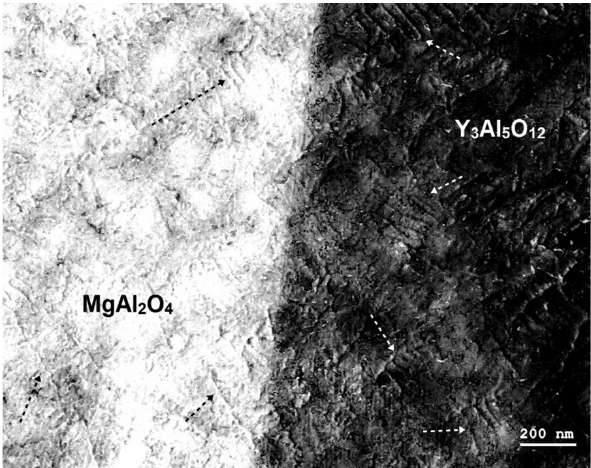
Figure 8: TEM images showing dislocation structures of MgAl 2 O 4 - Y 3 Al 5 O 12 phase boundary in the eutectic structure after the tensile test at